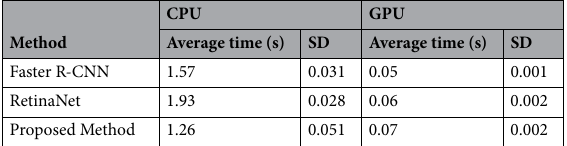
Table 5. Processing time evaluation of the analyzed approaches.